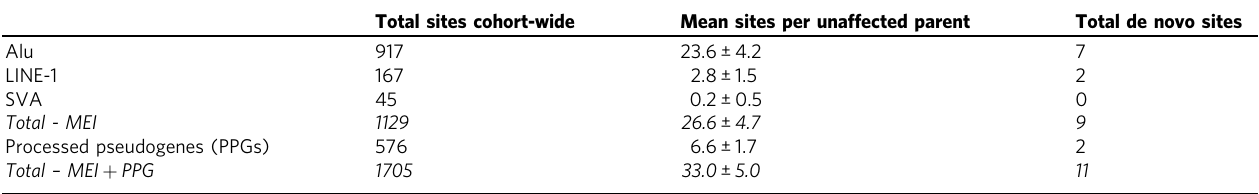
Table 1 RT variant discovery in the DDD study